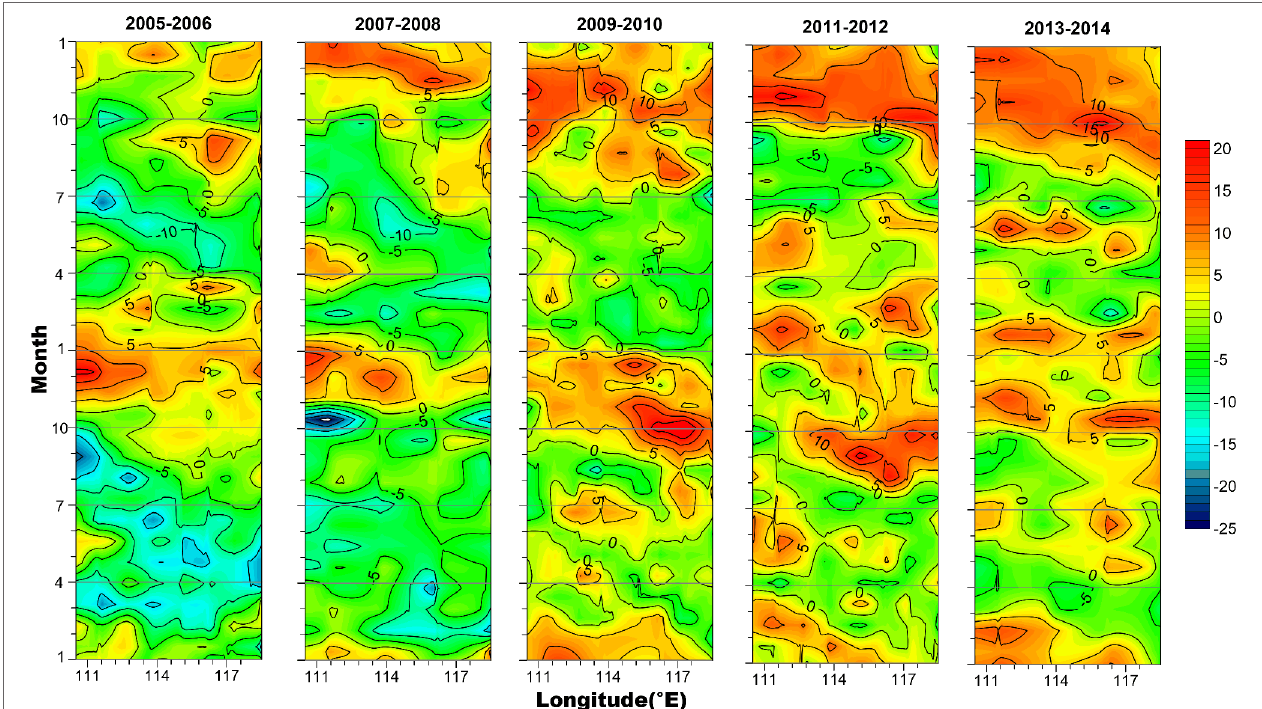
FIGURE 12 | The time/longitude distribution of the mean sea level anomaly (unit in cm, averaged within 0.3 latitude beyond 300 m isobath) on the slope of the northern SCS in the years from 2005 to 2014, derived from satellite along-track